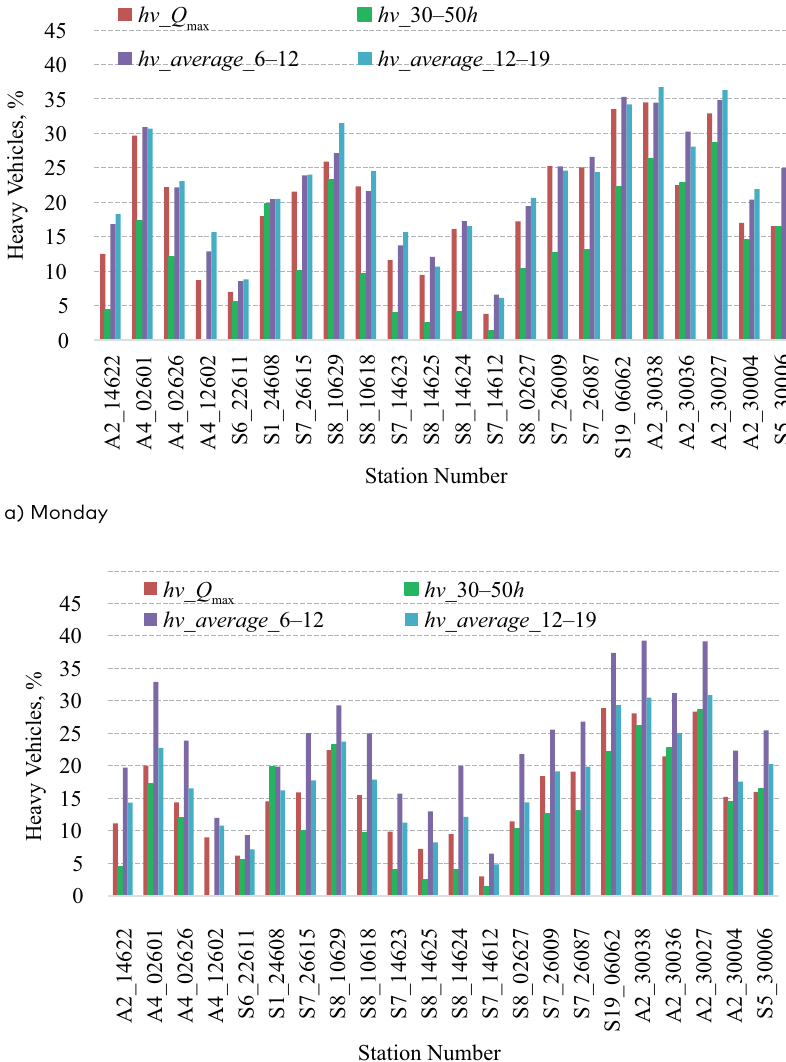
Figure 4. The share of heavy vehicles in